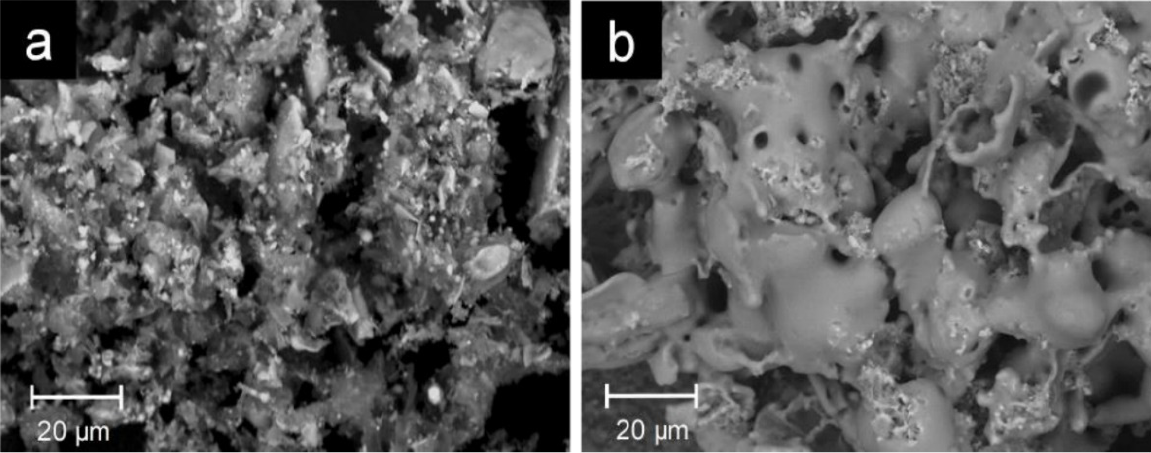
Figure 7. SEM of residues from interrupted isothermal TGA gasification of wheat straw char at 850 °C at ( a ) 25% conversion and ( b ) 90% conversion [96].